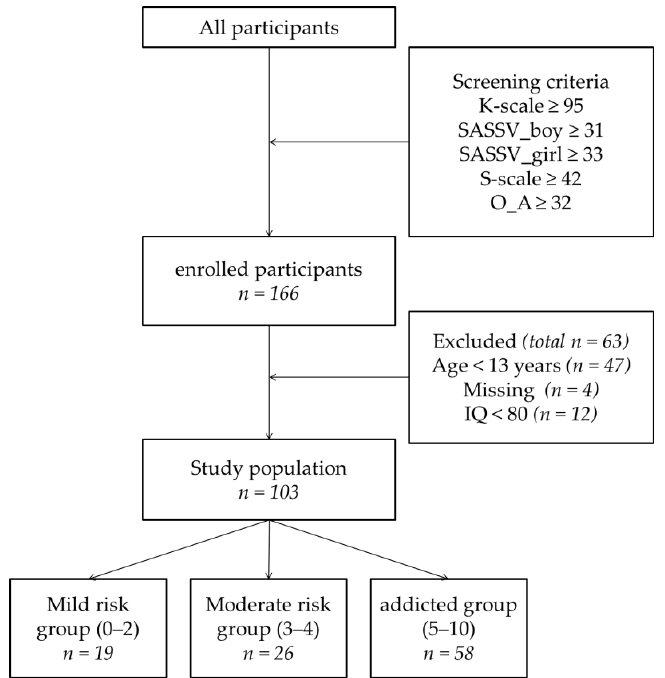
Figure 1. Study flow chart. NOTE: The screening cut-off values shown are those for adolescents; children were excluded from this analysis, and their scores are not reported here. The study participants were divided into subgroups according to their total DIA score. K-scale = Korean Scale for Internet Addiction for adolescents; SAS-SV = Smartphone Addiction Scale-short form version; S-scale = Korean Smartphone Addiction scale; O_A = Internet Addiction Proneness Scale for Adolescents checked by caregivers.